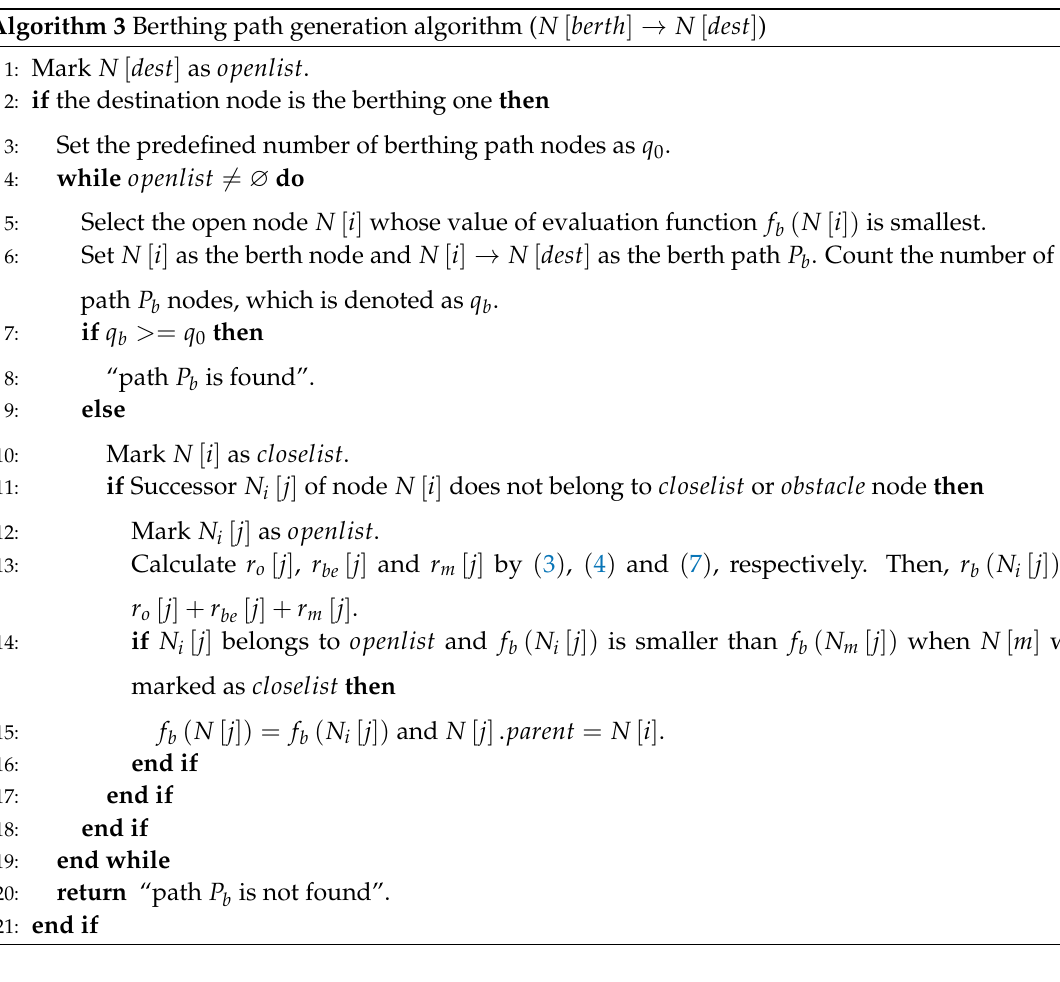
Algorithm 3 Berthing path generation algorithm ( N [ berth ] → N [ dest ]